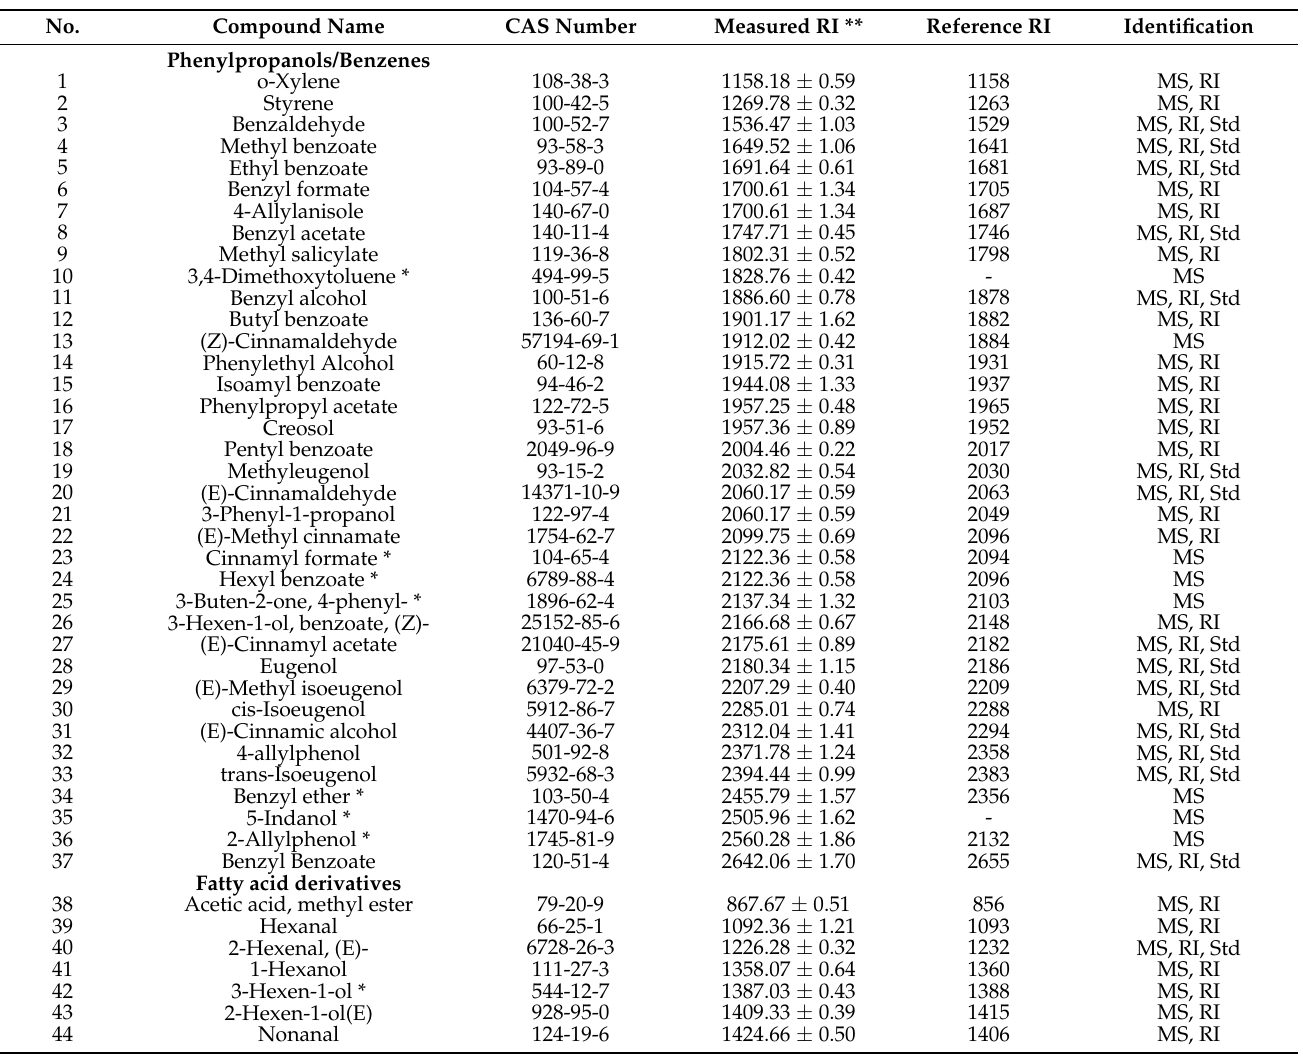
Table 1. Identification of volatile compounds in P. mume